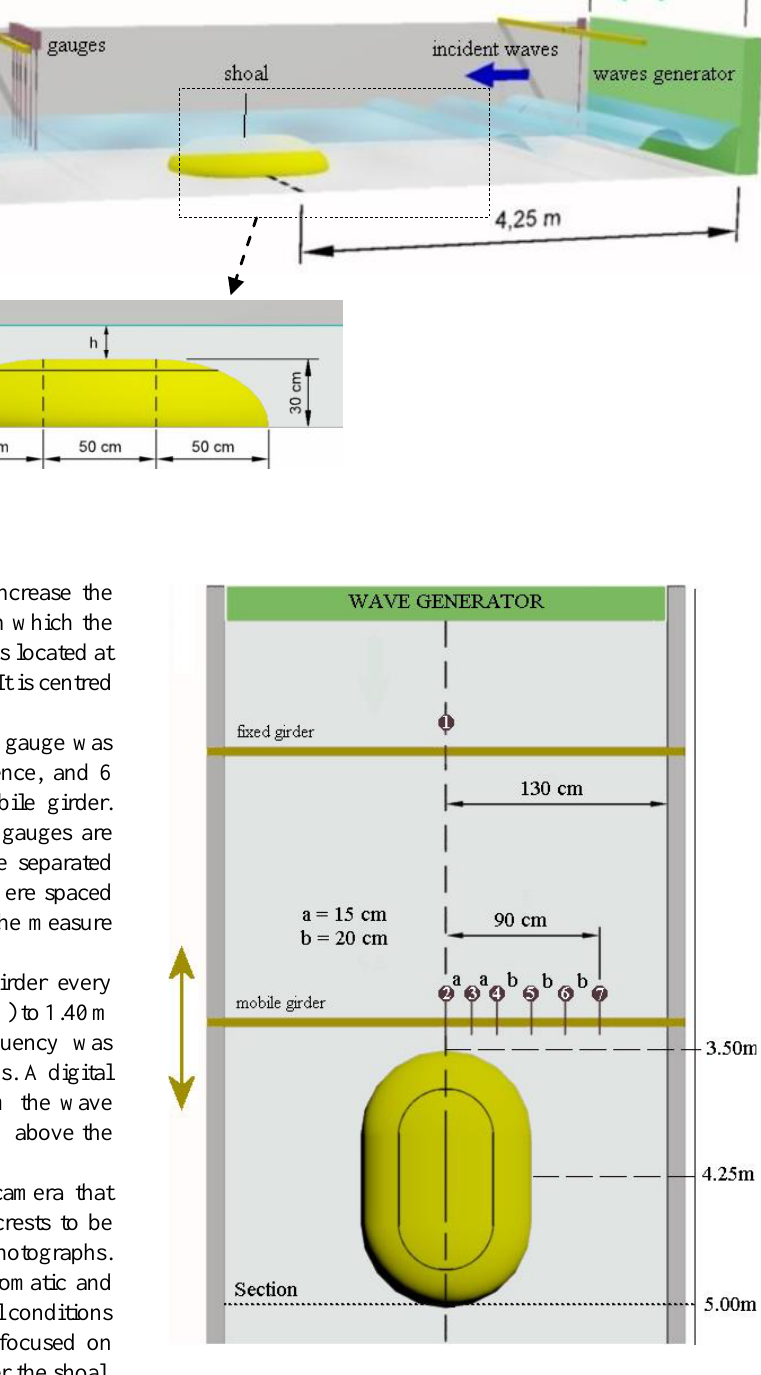
Fig. 2. Schematic plan view of the shoal and location of the wave Fig. 2: Schematic plan view of the shoal and location of the wave gauges.